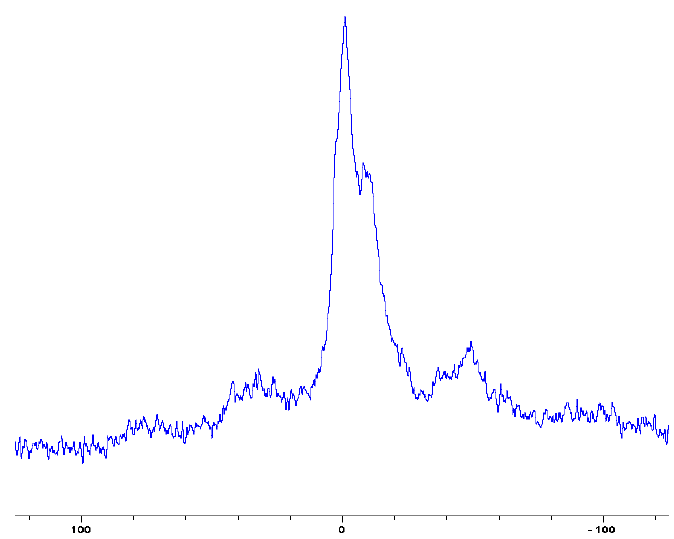
Figure 3. Solid-state 31 P-NMR spectrum of char obtained from fish gelatin + 9,10-Dihydro-9-oxa-10- phosphaphenanthrene-10-oxide (DOPO) (the abscissa denotes the chemical shift values, δ , in ppm and the ordinate corresponds to the signal intensity in arbitrary units).